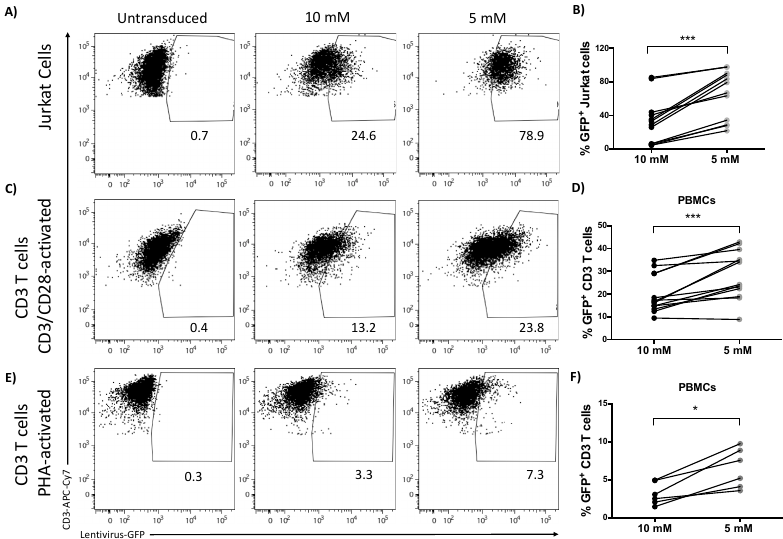
Figure 6. Lowering glucose levels increases the susceptibility of T cells to lentiviral transduction. Jurkat cells and PBMCs were transduced and maintained in 10 or 5 mM of glucose with a lentivirus containing GFP protein, expression of which was detected to follow transduction e ffi ciency. ( A ) Representative dot plot of untransduced and transduced Jurkat cells in di ff erent concentrations of glucose. ( B ) Percentage of GFP + Jukat cells after lentiviral transduction in di ff erent concentrations of glucose. ( C ) PBMC were preactivated for 48 h and GFP + CD3 T cells were detected 3 days after lentiviral transduction, representative dot plot, ( D ) and percentage of GFP + CD3 T cells after lentiviral transduction in the glucose concentrations indicated. ( E ) Representative dot plot of transduced CD3 T cells after activation with PHA for 72 h and ( F ) percentage of GFP + CD3 T cells transduced after PHA stimulation Wilcoxon paired t test, * p < 0.05, *** p <